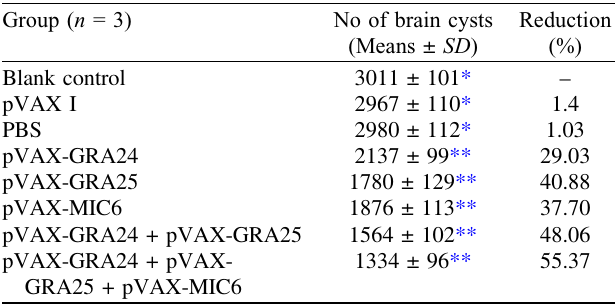
Figure 5. Survival rate of immunized Kunming mice followed by challenge with 1 (cid:2) 10 3 tachyzoites 2 weeks after the fi nal immunization. Table 1. Mean cyst burden per mouse brain 4 weeks after challenge with 20 cysts of Toxoplasma gondii Pru strain per